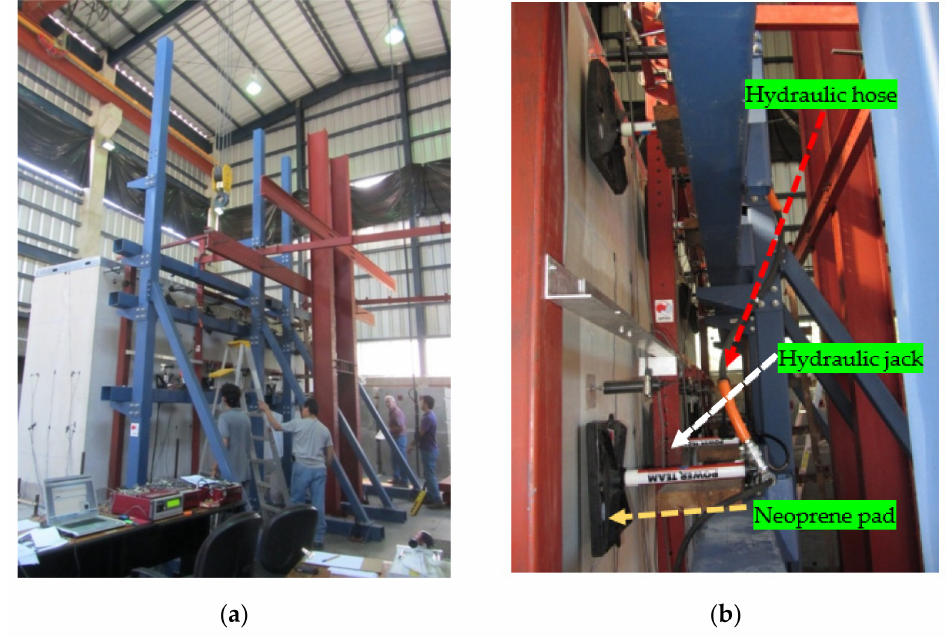
Figure 14. Load system acting on the specimen: ( a ) General view of the load frame; ( b ) Detail view of the load